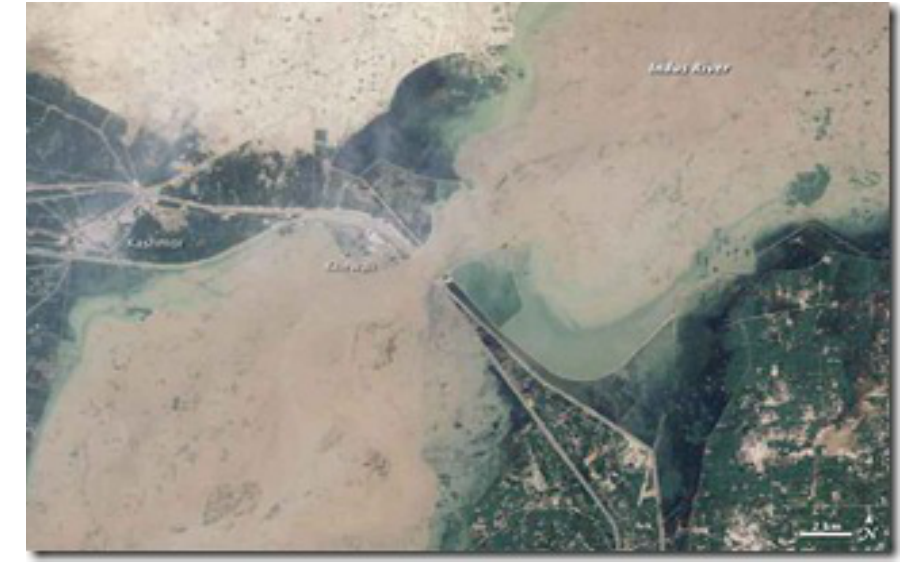
Figure 10 – After flood state in